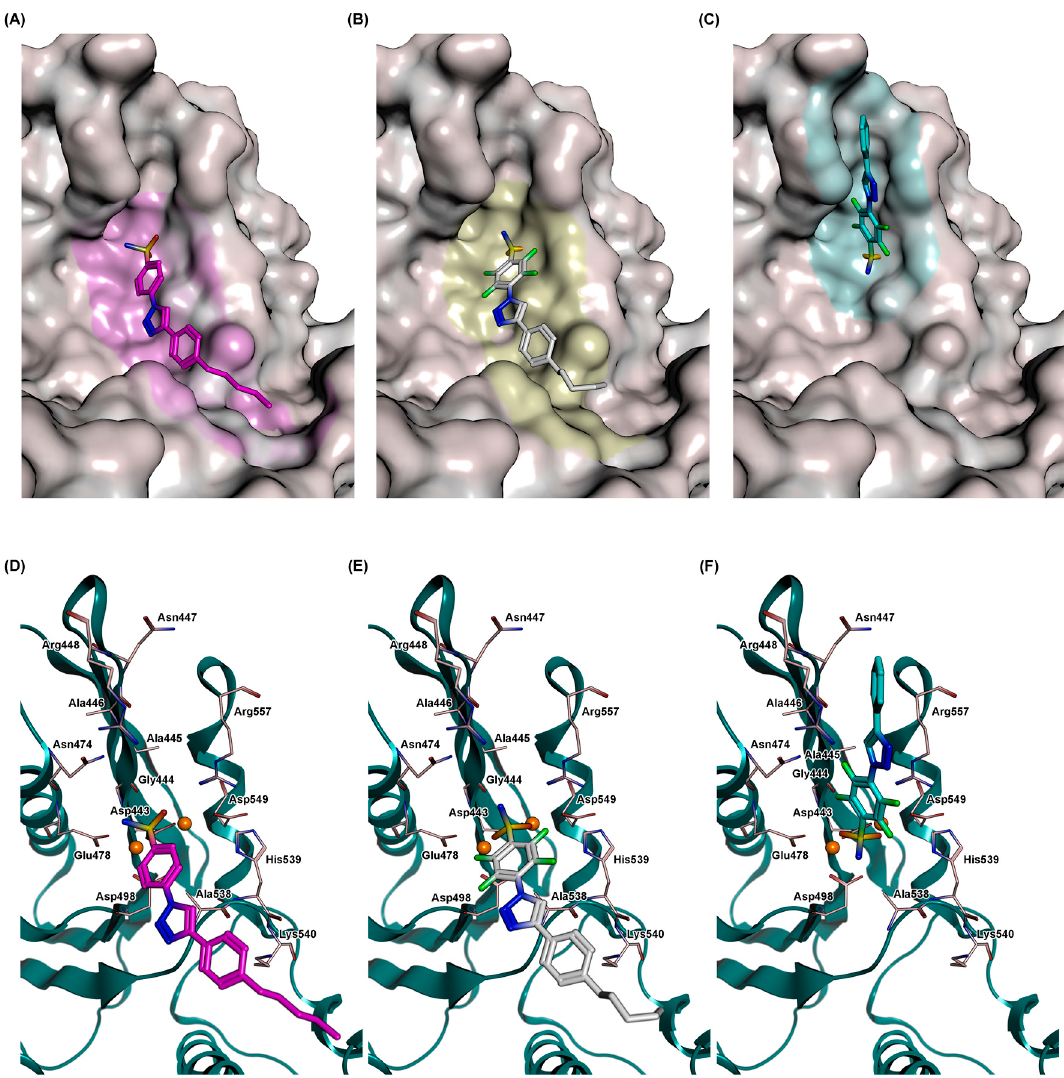
Figure 5. Predicted binding modes for the most active compounds 9d , 10c , and 10d within the HIV-1 RNase H catalytic site: ( A – C ) best docking pose for 9d (purple), 10c (cyan), and 10d (white), respectively, with the protein shown as grey surface, and with the contact residues colored in the same color as the docked ligand; ( D – F ) close views of the binding site, where the protein is depicted as cartoon (blue lagoon), side chains of relevant residues are provided as thick line (pink), and Mn 2+ metal cofactors as spheres (orange).